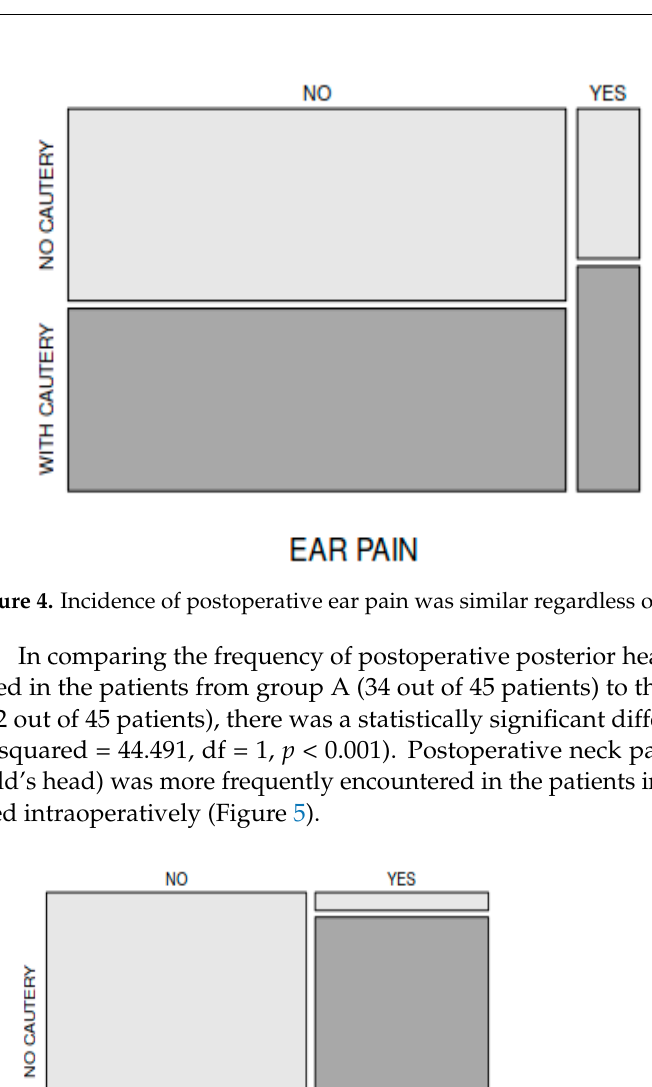
Figure 4. Incidence of postoperative ear pain was similar regardless of electrocautery use.